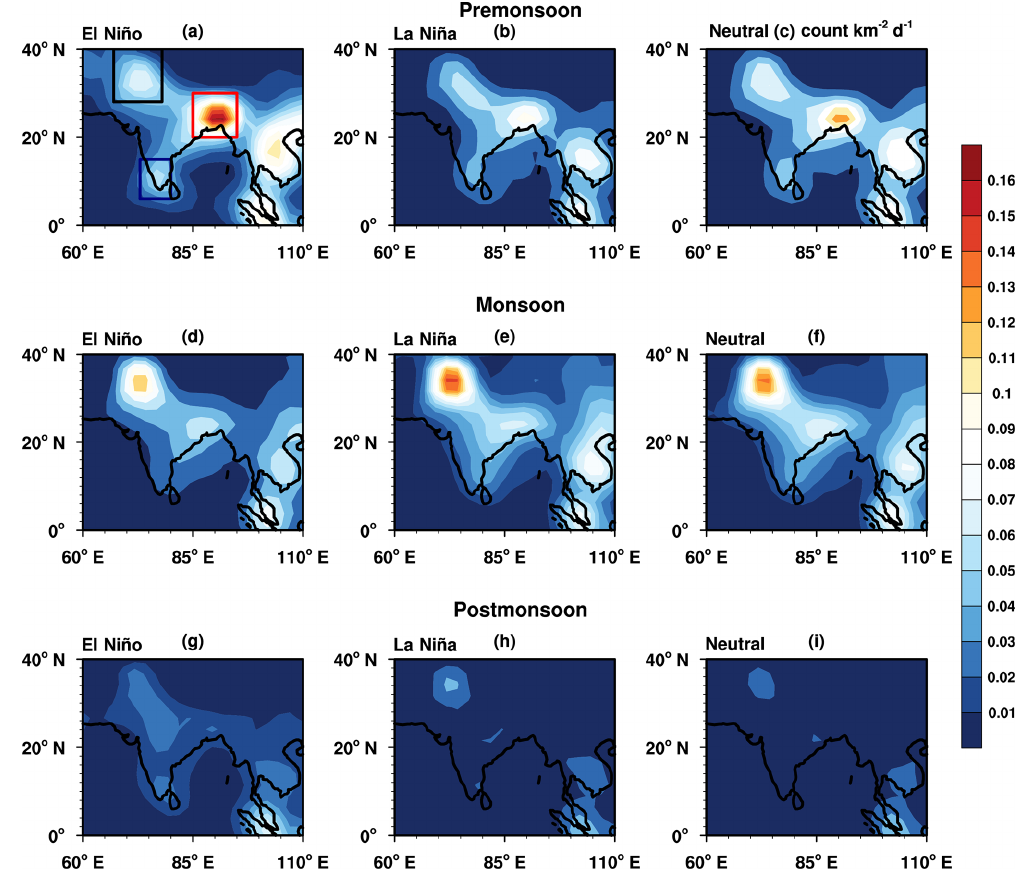
Figure 1. LFD composite during different ENSO phases. Coloured boxes in Fig. 1 a represents the hot spot regions of LFD (red box is NEI; black box is NNWI; blue box is SPI).